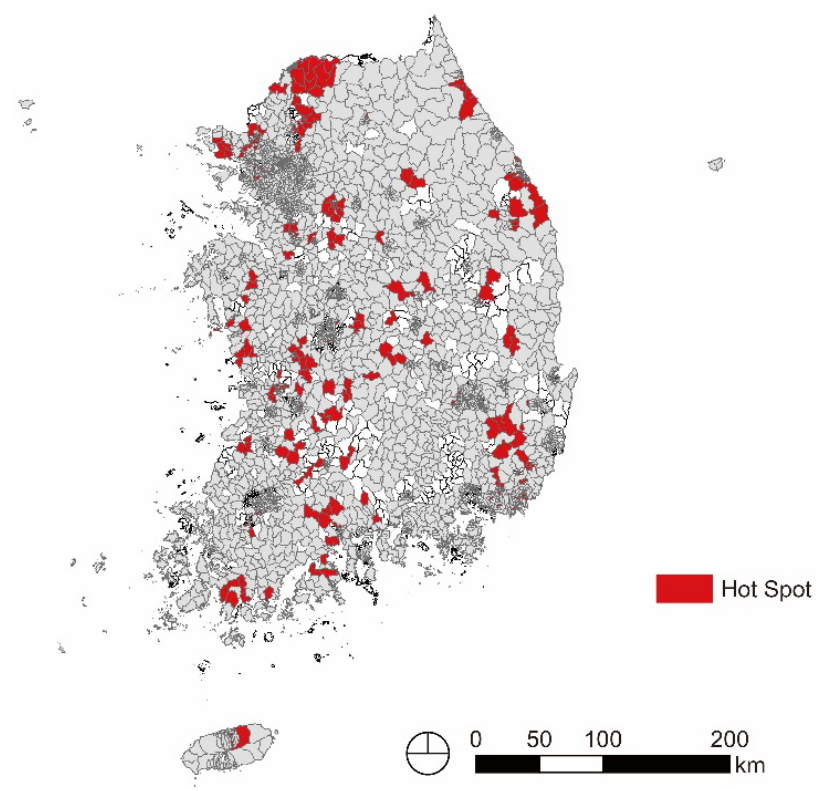
Figure 3. Hot spot of older adults’ depression.